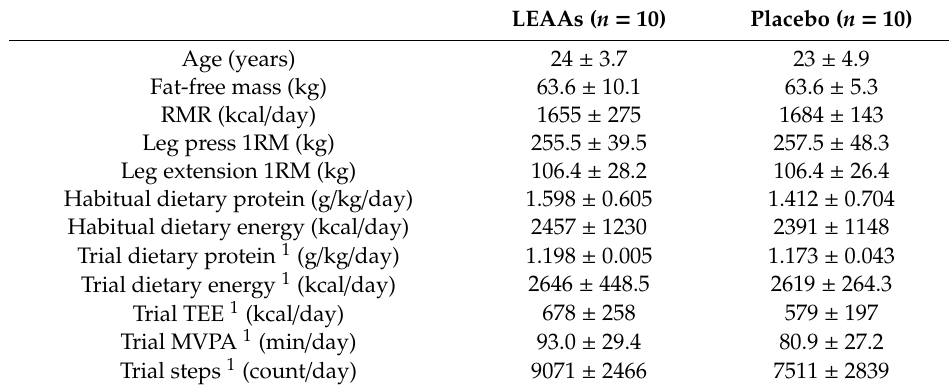
Table 1. Participant